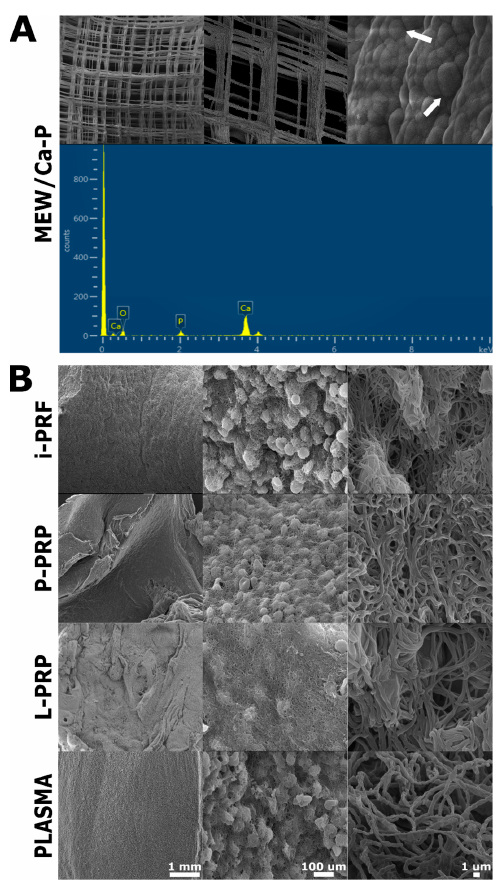
Figure 1. ( A ) SEM images from MEW scaffolds showing CaP surface deposition (far right image, white arrows) con fi rmed by energy-dispersive X-ray spectroscopy (EDX), as previously reported by our group [42]. ( B ) Surface characteristics of the di ff erent hemoderivatives including PLASMA.